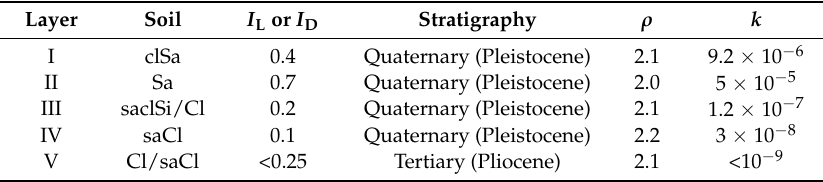
Table 1. Main geotechnical characteristics of the subsoil.